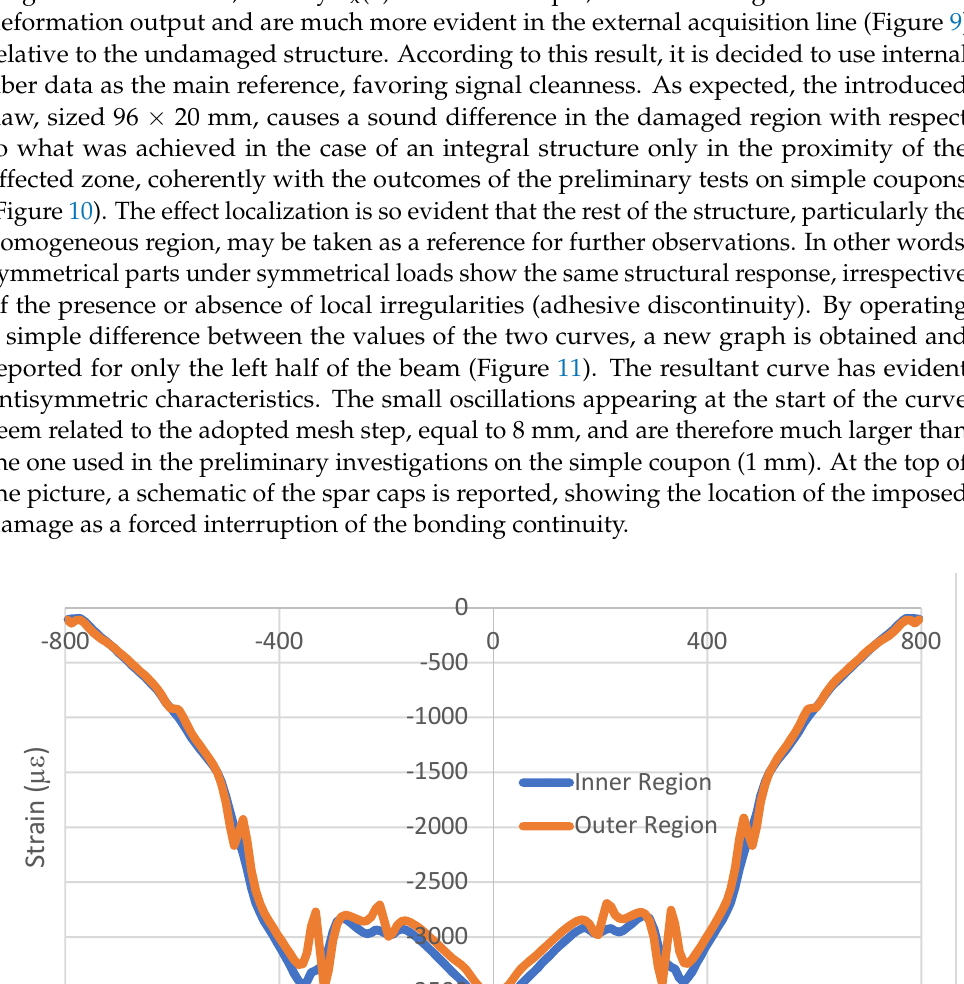
Figure 10. Strain profiles for locally de-bonded spar at the inner cap fiber. These preliminary results highlight and confirm some outcomes derived from the preliminary study of a simple coupon. In particular, for the investigated case (about 100 mm flaw), the following are confirmed: 1.